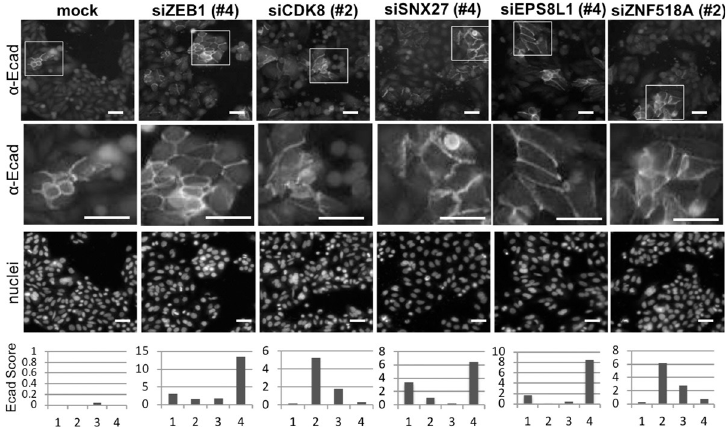
Fig 5. SW480-membrane associated E-cadherin can increase when negative regulators are knocked down. Representative images from the deconvoluted screen of α E-cadherin, 72 hours post transfection of selected duplex siRNAs (25nM, duplex # indicated in brackets) for mock, ZEB1 , CDK8 , SNX27 , EPS8L1 and ZNF518A . Scale bar; 50 μ M, 20x magnification with enlarged images for E-cadherin shown below. Hoechst staining shows cell nuclei. Mock normalised Ecad score for individual siRNA (numbered 1–4) in the deconvolution screen is shown below.